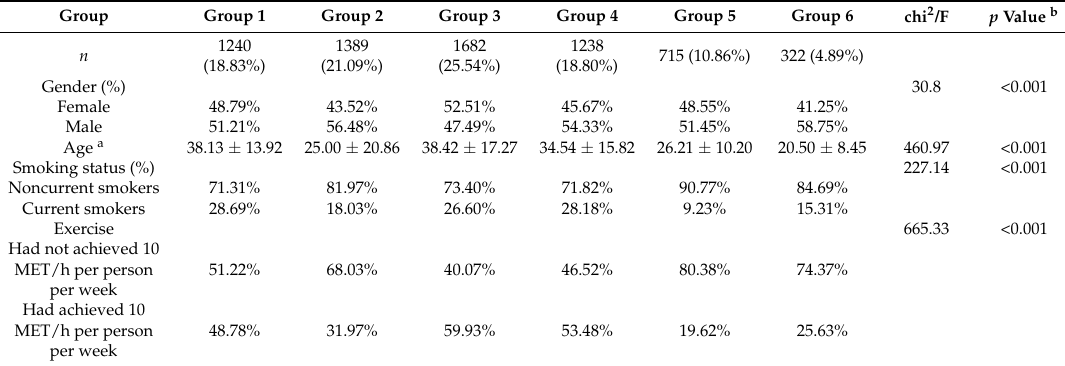
Table 1. Participants’ characteristics by trajectory groups at the baseline.